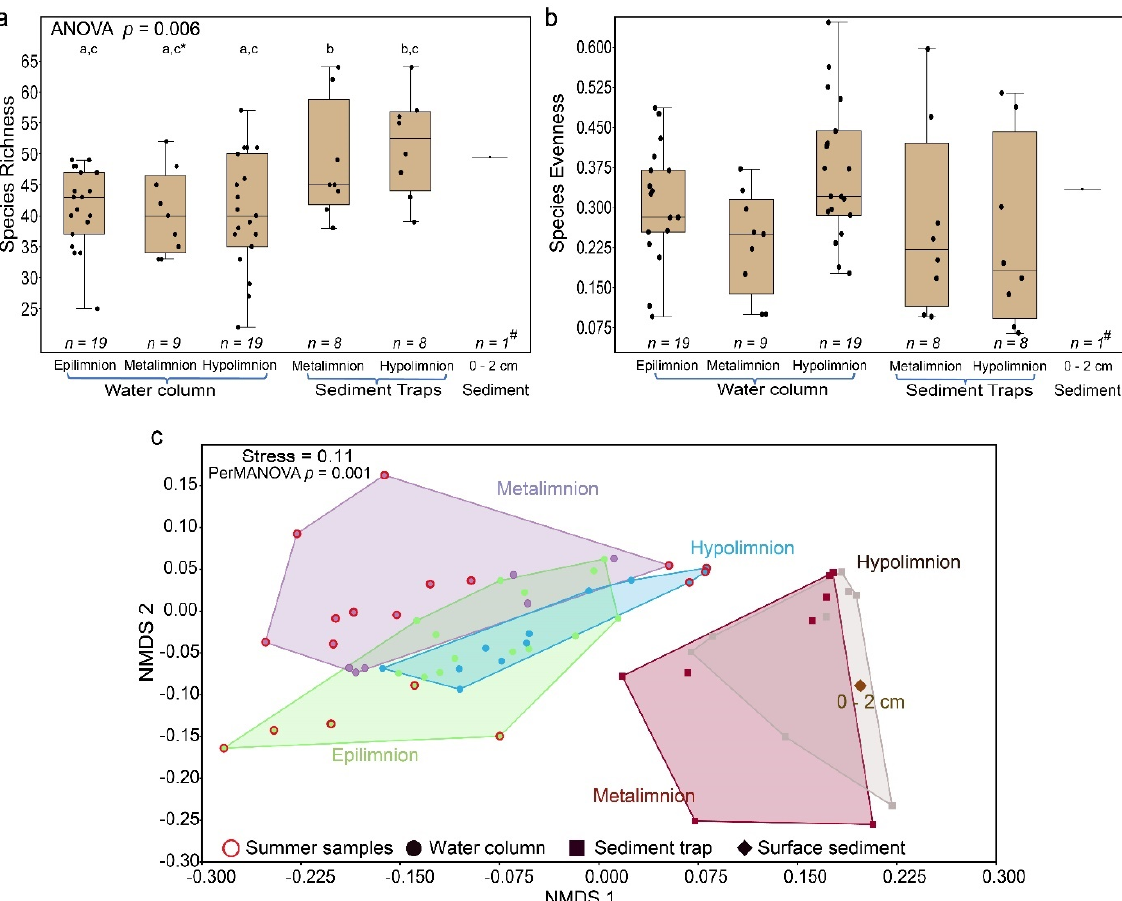
Figure 5. Alpha and beta diversity of cyanobacteria communities in Lake Tiefer See: Alpha diversity of cyanobacteria community composition in the water column, trap, and surface sediments where ( a ) ANOVA test for equal means on species richness followed by Tukey’s pairwise tests; a = non-significant zones in water column, b = non-significant zones in sediment traps, c = significance in hypolimnion traps, and * = marginal significance. # = one sample representing the mean of biological triplicates; ( b ) ANOVA test for equal means on Pielou’s species evenness among the groups was not significant p = 0.07, and ( c ) Visualization of beta diversity via a non-metric multidimensional scaling (NMDS) of cyanobacteria community composition in the water column, trap material, and surface sediments based on Bray–Curtis dissimilarity.